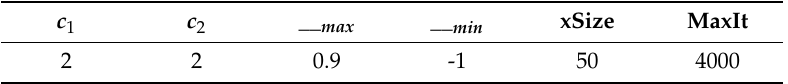
Table 2. The relevant parameters of the particle swarm optimization (PSO)